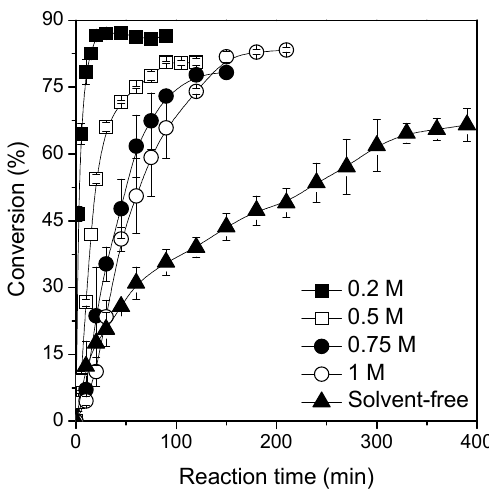
Figure 4. Effect of reactants concentration and organic solvent on the ester synthesis. The reactions were performed at 56 °C, 240 rpm, acid:alcohol molar ratio 1:3, and biocatalyst concentration of 800 U of activity by using TLL–Octyl–SiO 2 as biocatalyst.